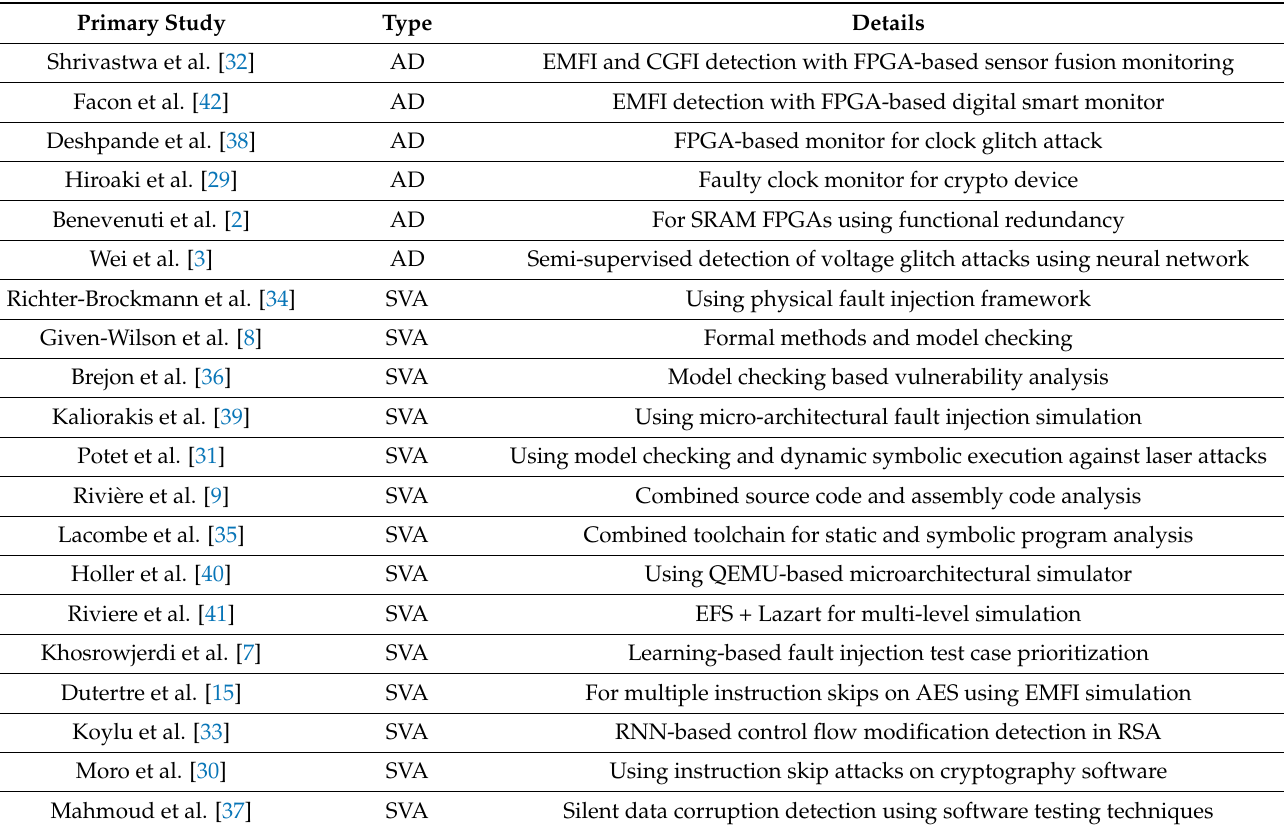
Table 2. Overview of primary